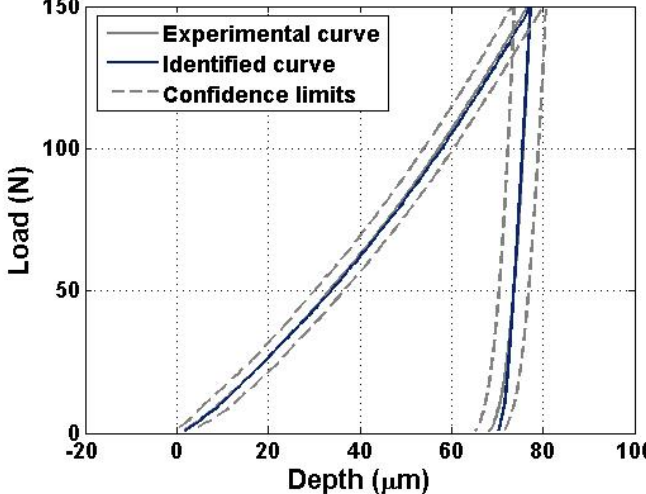
Figure 1: Comparison between the experimental mean indentation curves obtained from conical (Rockwell) tests on an Al/TiB 2 specimen with 50% TiB 2 weight content and the corresponding curves recalculated by a FE model of the test, supplemented by the identified material parameter